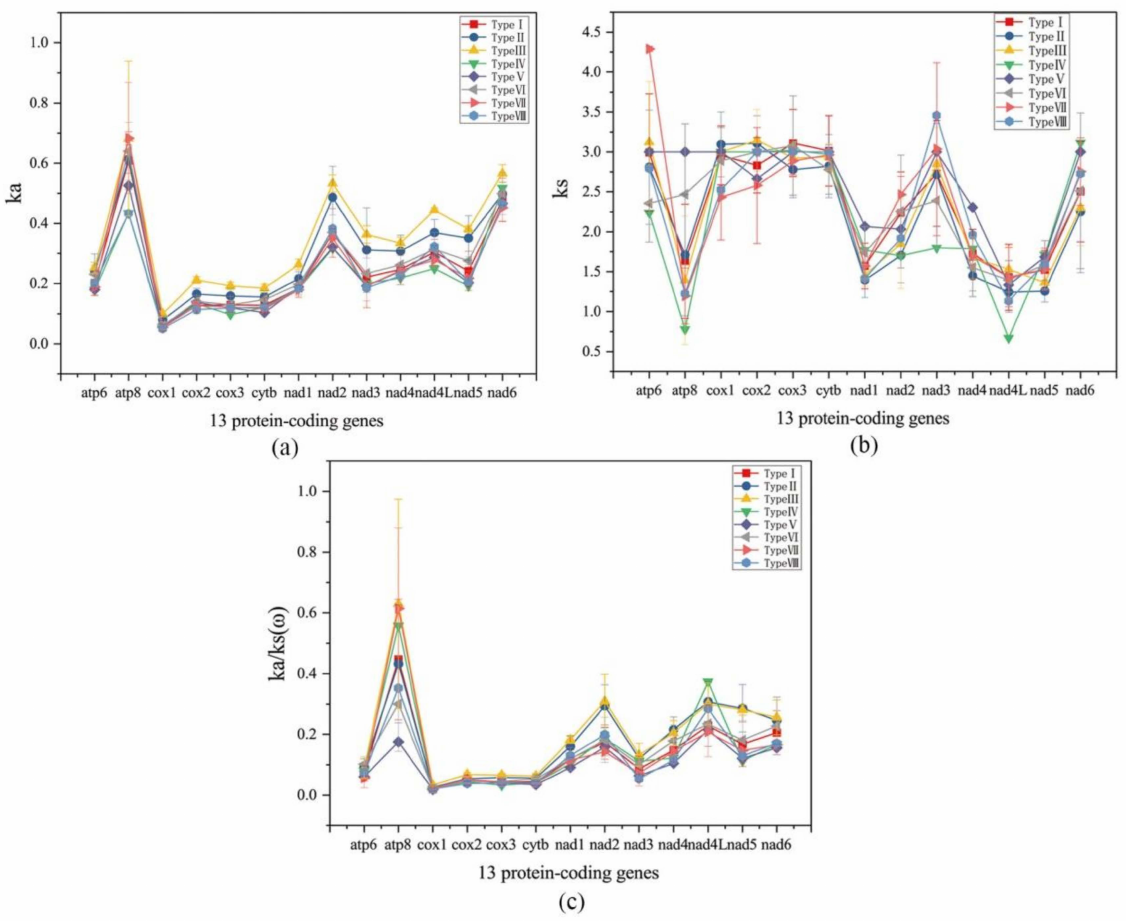
Figure 7. Natural selection strength and the ratio of non-synonymous to synonymous substitutions ( ω ) were calculated in codeML for the 13 protein-coding mitochondrial genes of the eight Ensifera gene arrangement types. ( a ) ka, ( b ) ks, and ( c ) ka/ks( ω ).